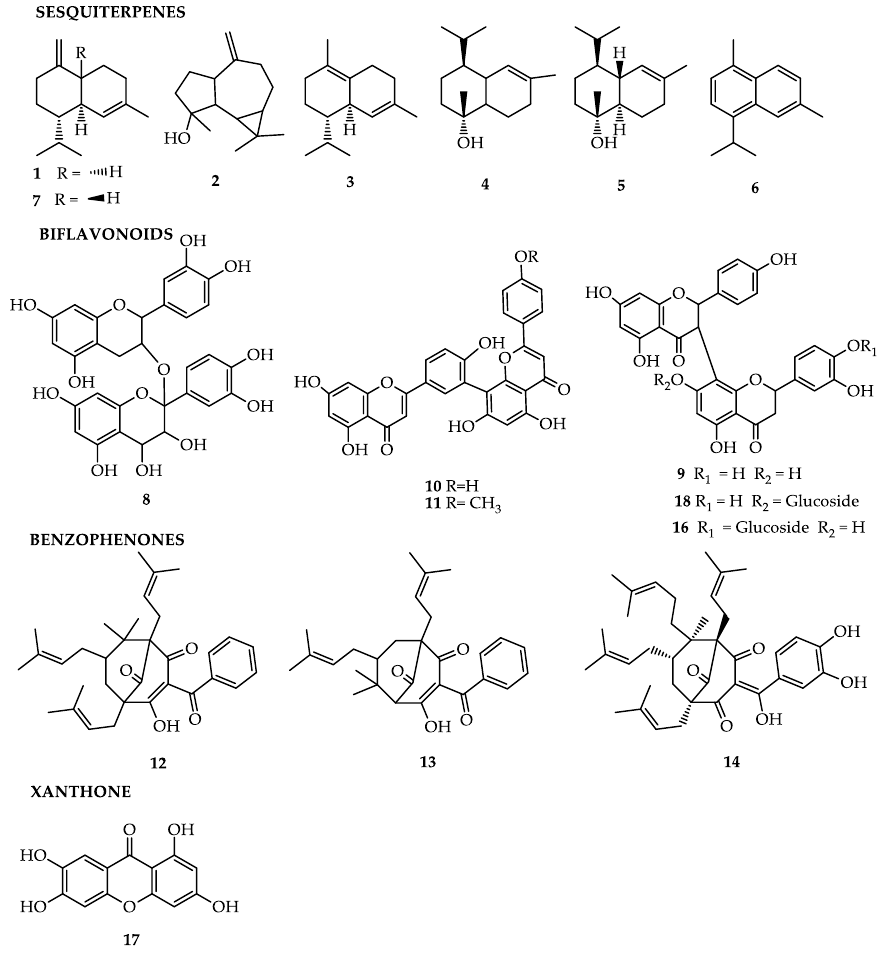
Figure 1. Bioactive compounds of Garcinia brasiliensis.